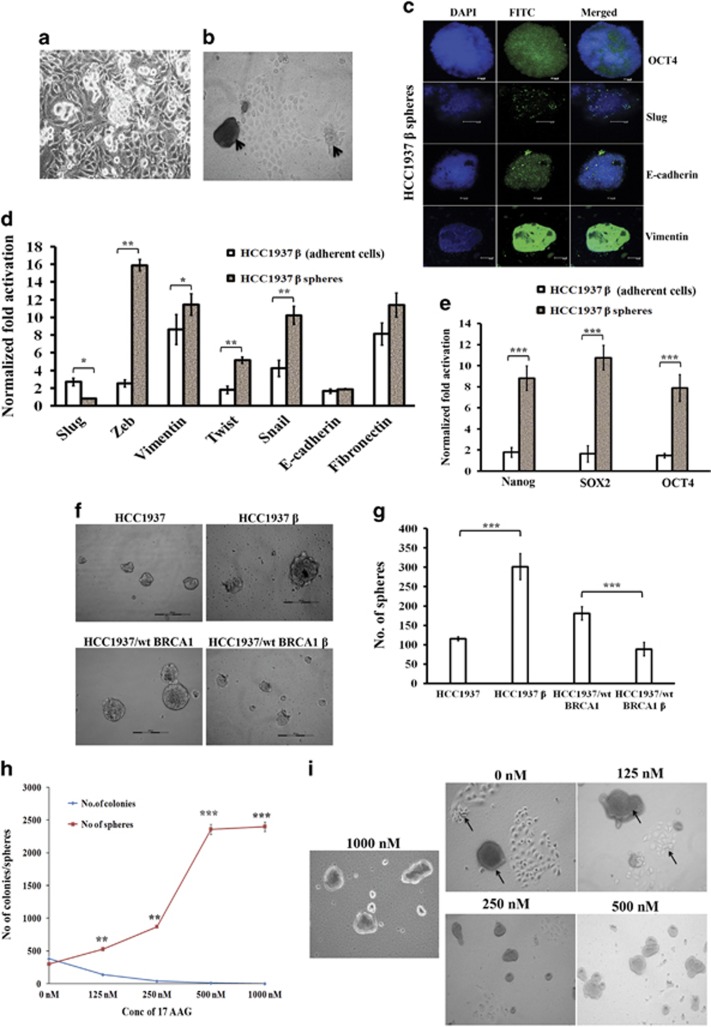
β-hCG induces stemness in HCC1937. (a) Sphere formation upon β-hCG overexpression in HCC1937 cells. (b) Arrows indicate the formation of spheres from adherent cells. (c) Immunoflourescence analysis of OCT4, Slug, E-cadherin and Vimentin in spheres derived from HCC1937 β. (d) qRT-PCR analysis of EMT markers (Slug, Zeb, Vimentin, Twist, Snail, E-cadherin and fibronectin) in the spheres and adherent cells of β-hCG overexpressed HCC1937. (e) qRT-PCR analysis of stem cell markers (Nanog, SOX2 and OCT4) in the spheres and adherent cells of β-hCG overexpressed HCC1937. (f) Mammosphere forming ability in non-adherent plates on day 4 in HCC1937, HCC1937/wt BRCA1, HCC1937 β and HCC1937/wt BRCA1 β. (g) Mammosphere with a minimum size of 50 μm from HCC1937, HCC1937/wt BRCA1, HCC1937 β and HCC1937/wt BRCA1 β was counted manually. All the experiments were done in triplicates. (h) Number of spheres (>50 μm in size) and number of adherent colonies (>around 50 cells/colonies) were counted manually in β-hCG overexpressing HCC1937 after treating with indicated doses of drug, 17AAG for 72 h. (i) Representative images of colony forming and sphere forming ability of β-hCG overexpressing HCC1937 (HCC1937 β) after treating with indicated doses of 17AAG for 9 days. All error bars in the graphs represent s.d.